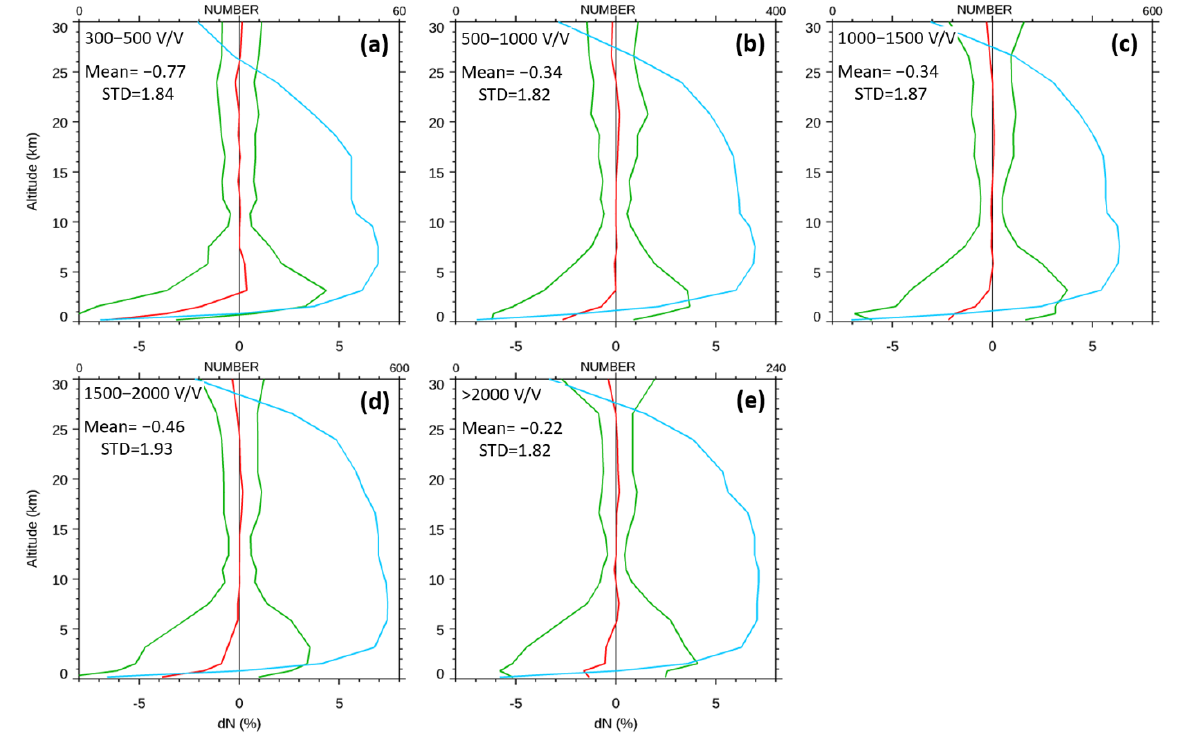
Figure 11. The same as Figure 10 but for fractional residual between refractivity simulated from STAR retrievals and refractivity simulated from RAOB; COSMIC-2 retrievals for October 2019. Imposed “Mean” and “STD” values are computed by averaging from 0 km to 20 k m.